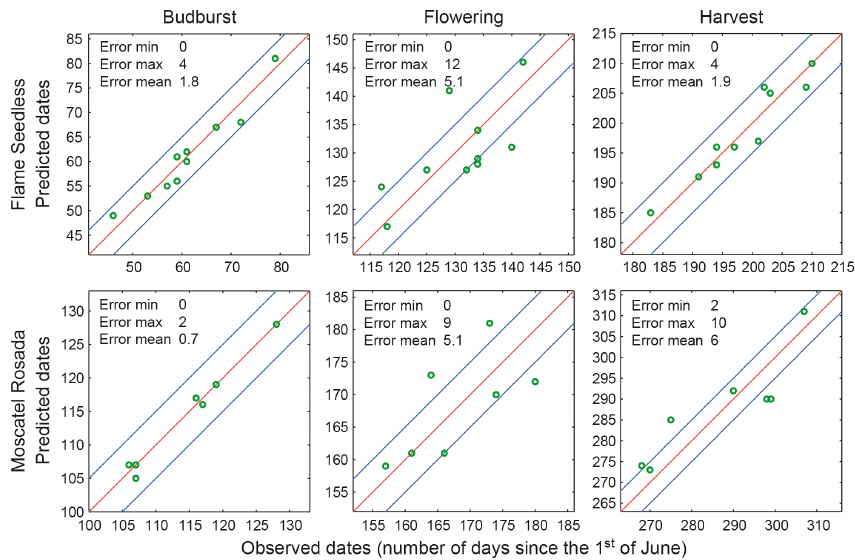
Figure 2. Observed vs. predicted dates of budburst, full bloom and harvest at the INIA experimental site. The dates are expressed in number of days since 1 June. The minimum, maximum and mean absolute errors (in days) are given for each variety and stage of growth. The upper and lower blue lines indicate delays of ± 5 days between observed and predicted dates, respectively. Table 1. Goodness-of-fit (calibration) and predicting performance (validation) of the phenological models. RMSE, Root Mean Square Error; NSE, Nash-Sutcliffe Efficiency; Bias, mean difference between the observed and predicted dates. Calibration (whole dataset) Leave-one-out cross-validation Flame Seedless Moscatel Rosada Flame Seedless Moscatel Rosada